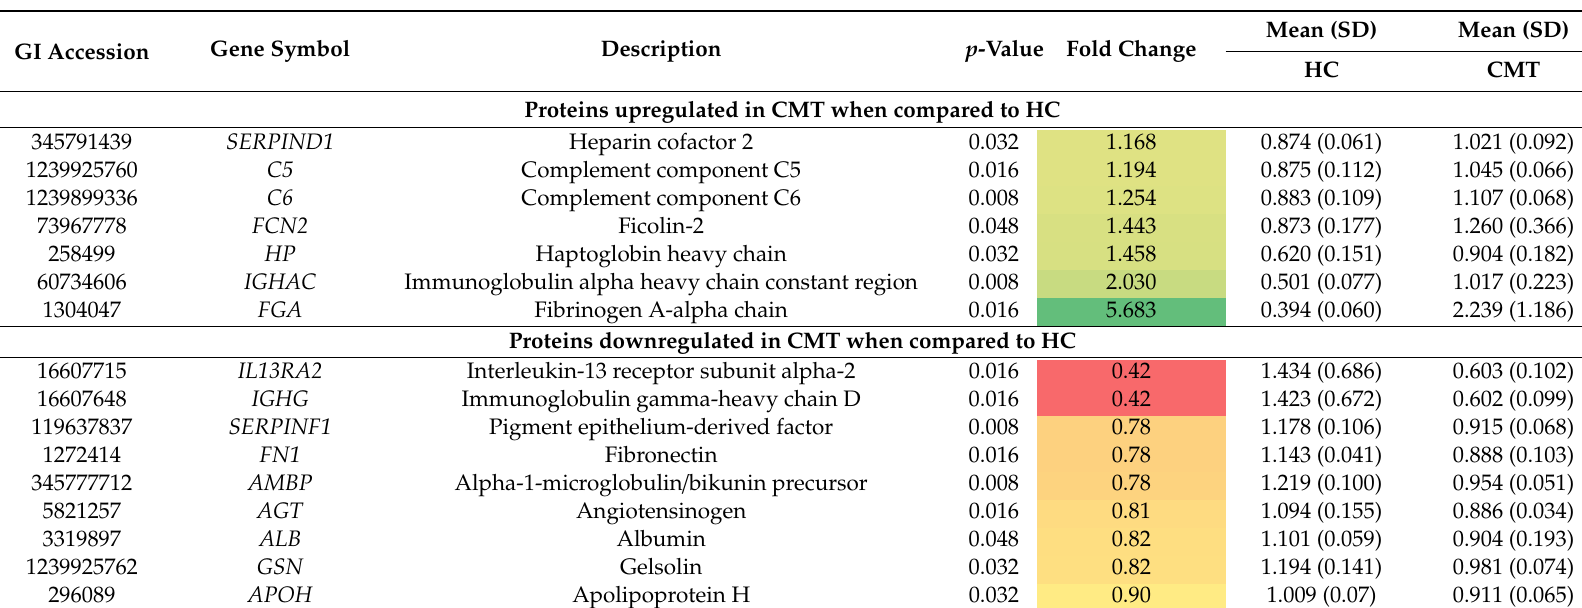
APOH 0.911 (0.065) Color represent relative abundance of the protein (red for downregulated, green for